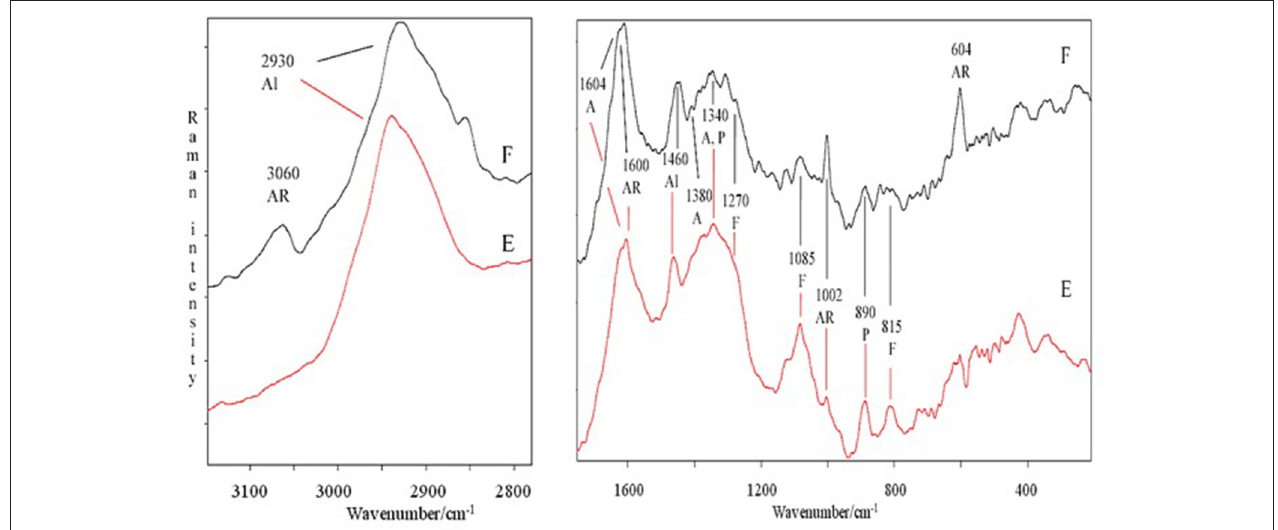
FIGURE 2 | Comparison of FT-Raman spectra of E and F extracts derived from Ascophyllum nodosum in the 3,100–2,800 and 1,700–200 cm − 1 regions. Abbreviations as in Figure 1 ; in addition, F, fucoidans.